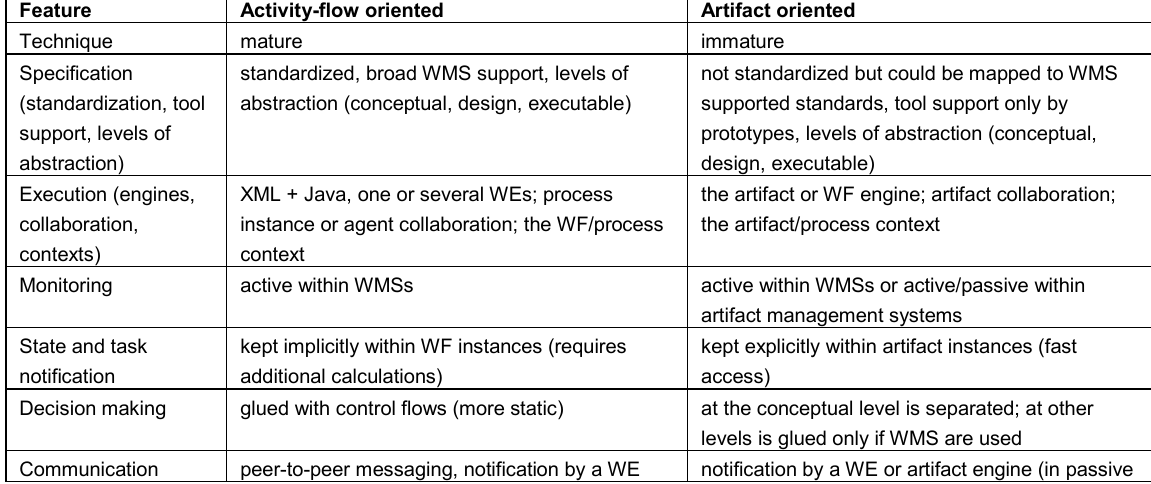
Table 1. Characteristics of the activity-flow and business artifact oriented paradigms